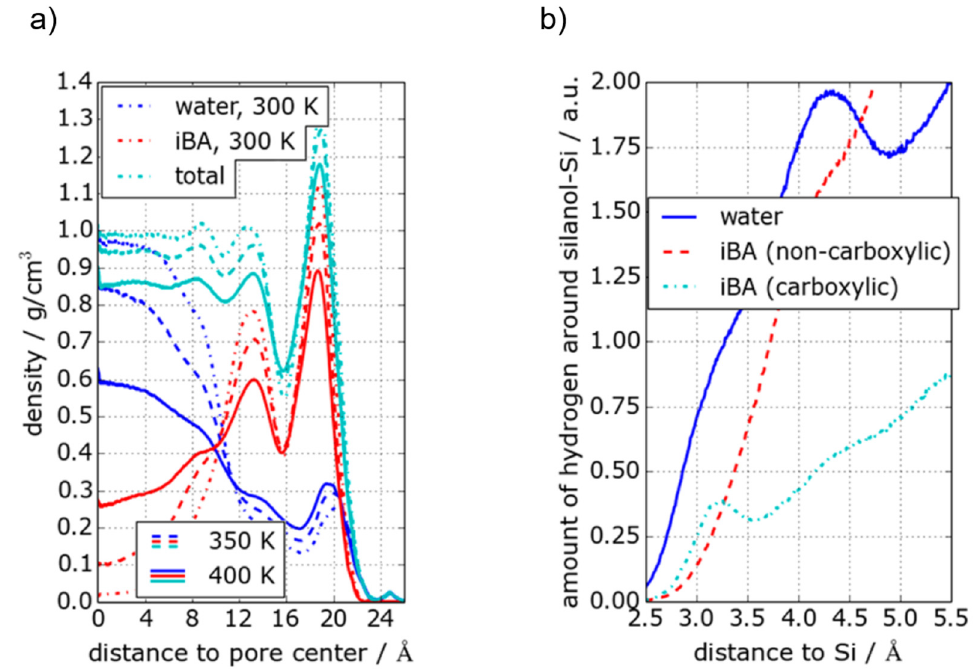
Figure 10. a ): density profiles for iBA and water calculated by molecular dynamics simulations. The center of Table 0. Å. ( b ): Density of hydrogen atoms as a function of the distance to the closest surface silanol group (figure reproduced from [256] with permission, copyright American Chemical Society).